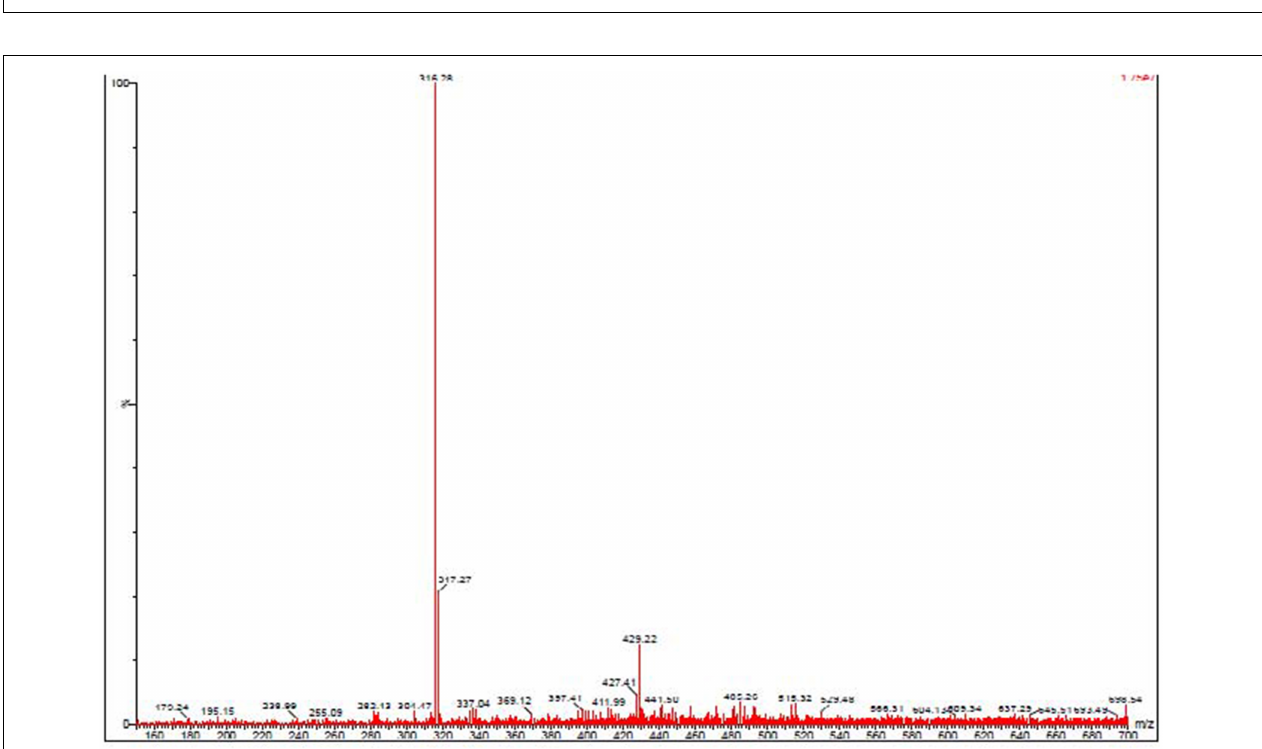
FIGURE 2 | Neighbor-joining phylogenetic tree based on 16S rRNA gene sequence of JAJ13 shows the relationships between JAJ13 and related species of the genus Streptomyces . Actinopolyspora mortivallis T was used